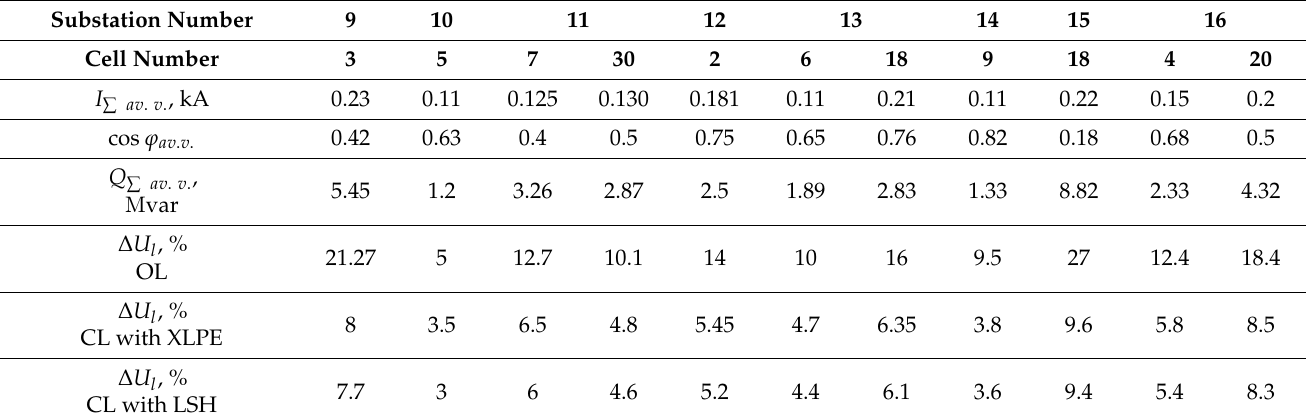
Table 5. Voltage losses in nodes with a maximum average current load at a known active power factor at